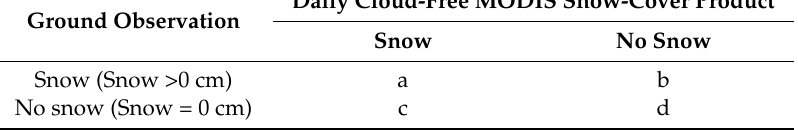
Table 1. Confusion matrix comparing daily cloud-free MODIS (Moderate Resolution Imaging Spectroradiometer) snow cover product against in situ